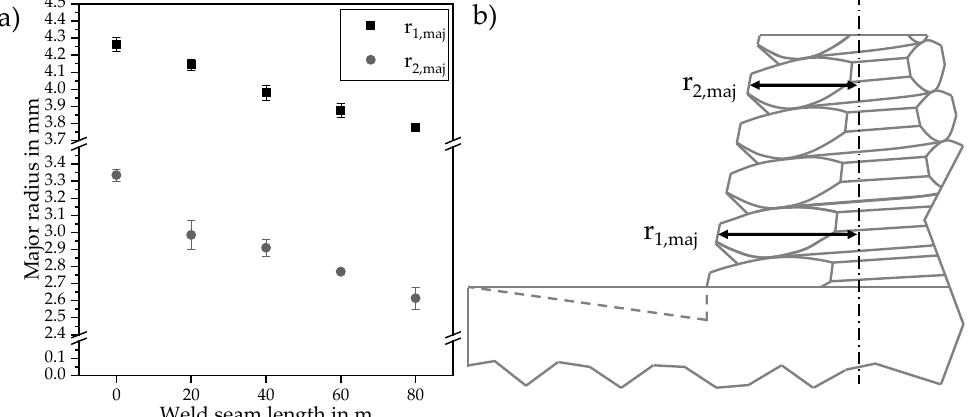
Figure 7. Wear deviation of the major thread radius as a function of the weld seam length in ( a ) measured with stripe light projection and ( b ) at the measuring points.